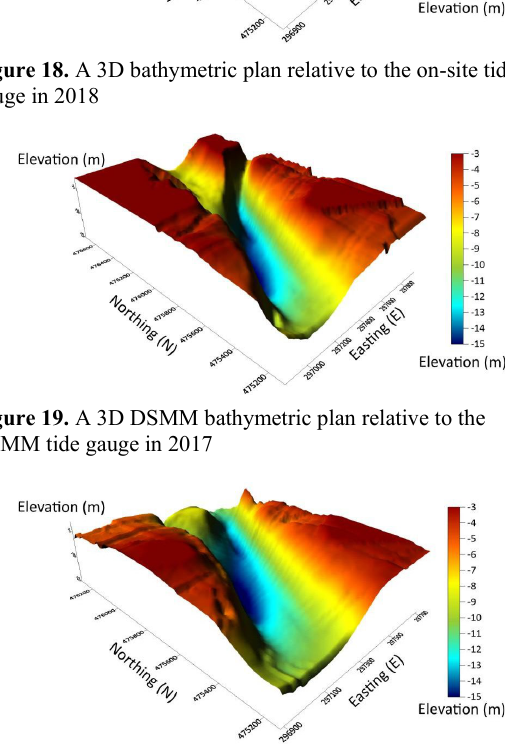
Figure 20. A 3D DSMM bathymetric plan relative to the DSMM tide gauge Plan in 2018